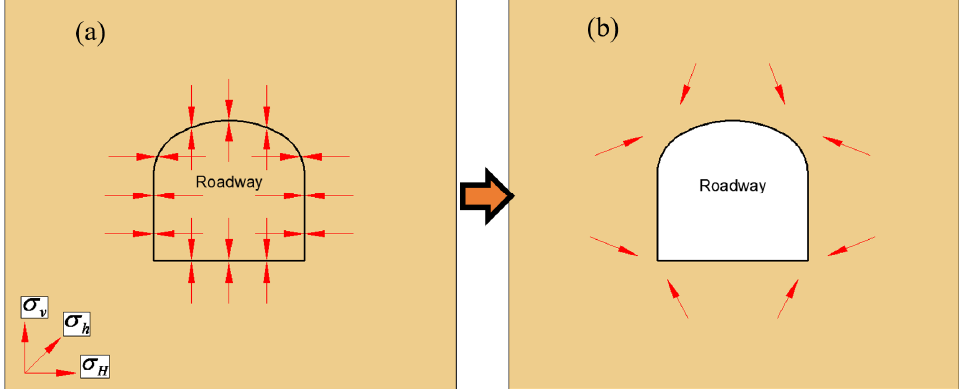
Figure 1. The stress field evolution caused by excavation in deep engineering. ( a ) Stress state before excavation. ( b ) Release of normal stress and concentration of tangential stress after excavation.